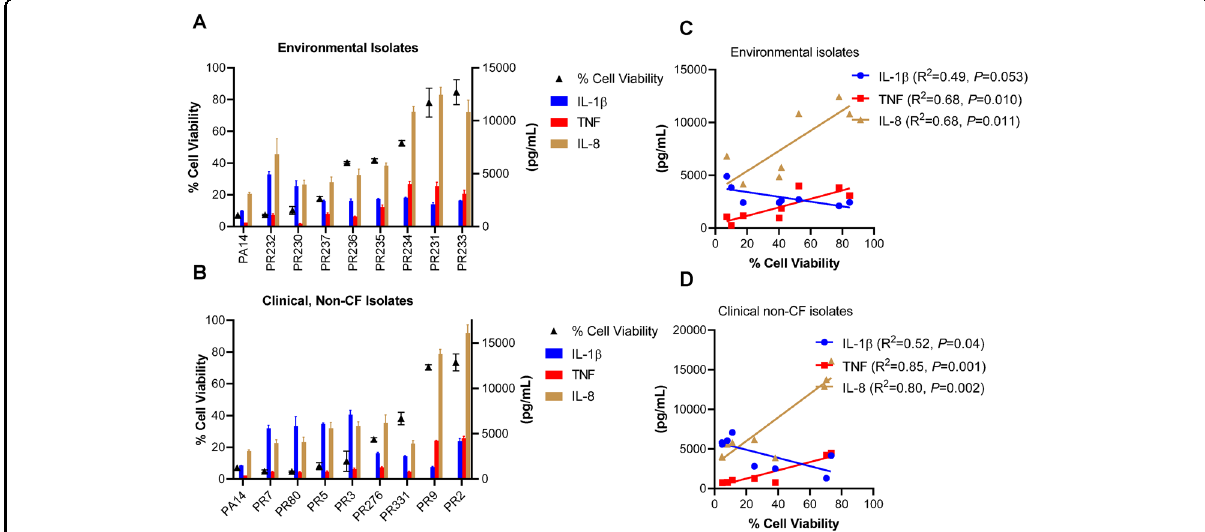
Fig. 5 Environmental and clinical, non-CF P. aeruginosa isolates also generally exhibit an inverse relationship between induction of cell death and TNF and IL-8 expression. THP-1 macrophages were seeded as described in Fig. 1. Environmental P. aeruginosa isolates from river water ( A ) and clinical P. aeruginosa isolates from non-CF patients (i.e., blood, wound, and urinary tract infections) ( B ) were used to infect THP-1 macrophages at 1 MOI. Cell viability and IL-1 β , TNF, and IL-8 production were measured at 3 h postinfection as described in Fig. 1. Simple linear regression analyses were conducted to determine the relationship between cell viability and cytokine expression for infections with ( C ) environmental and ( D ) non-CF isolates. Mean ± SD of triplicates of a pool of >3 experiments are